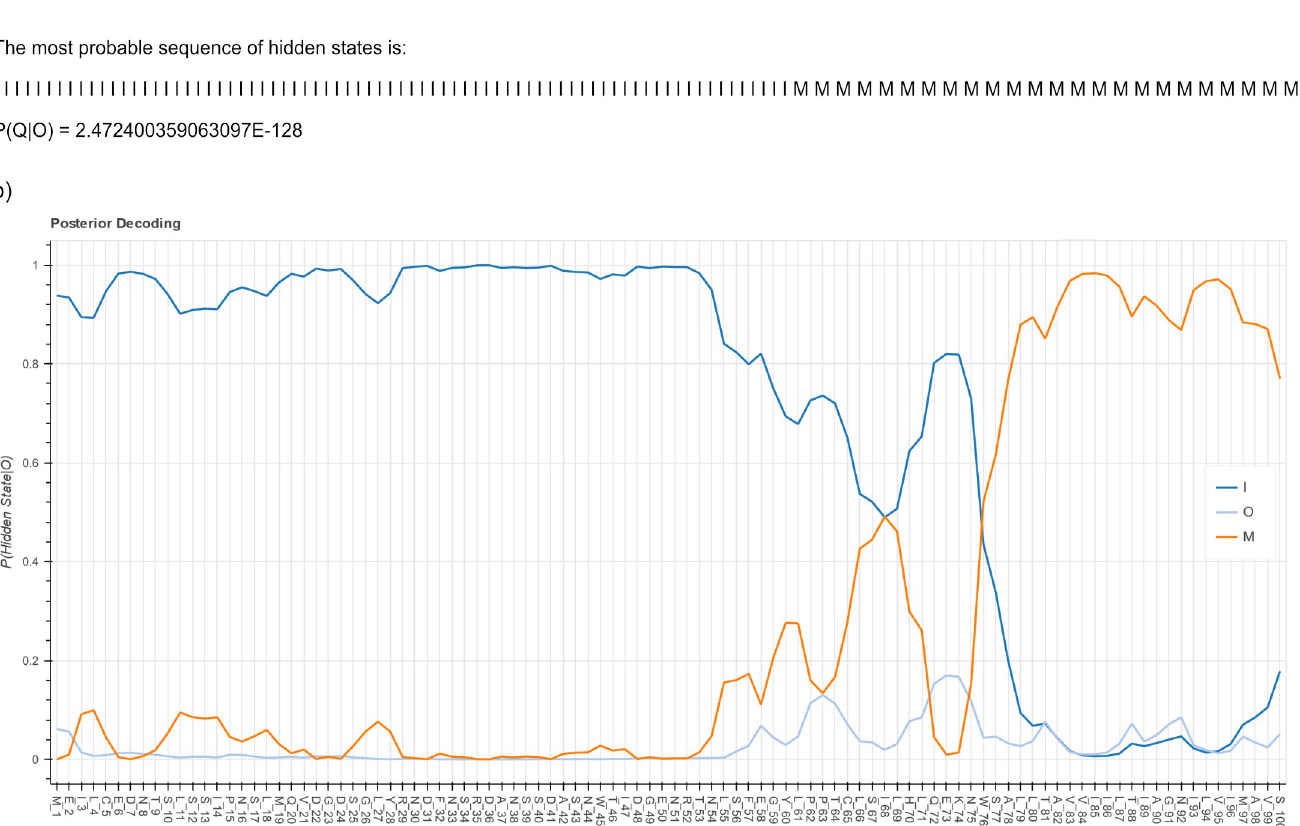
Fig 2. Results of Viterbi and Backward algorithms for the prediction of membrane segments in our example protein sequence. (A) Viterbi prediction of the most probable sequence of hidden states: Inside (I), Membrane (M), and Outside (O), per input protein sequence position. In the HMMTeacher Viterbi output, Q is the sequence of hidden states. The letter O inside the probability is the sequence of observed states. P(Q|O) is the conditional probability of the hidden states given the sequence of observed states. (B) Posterior decoding chart derived from running the Backward algorithm in all observed protein sequence positions for all hidden states.